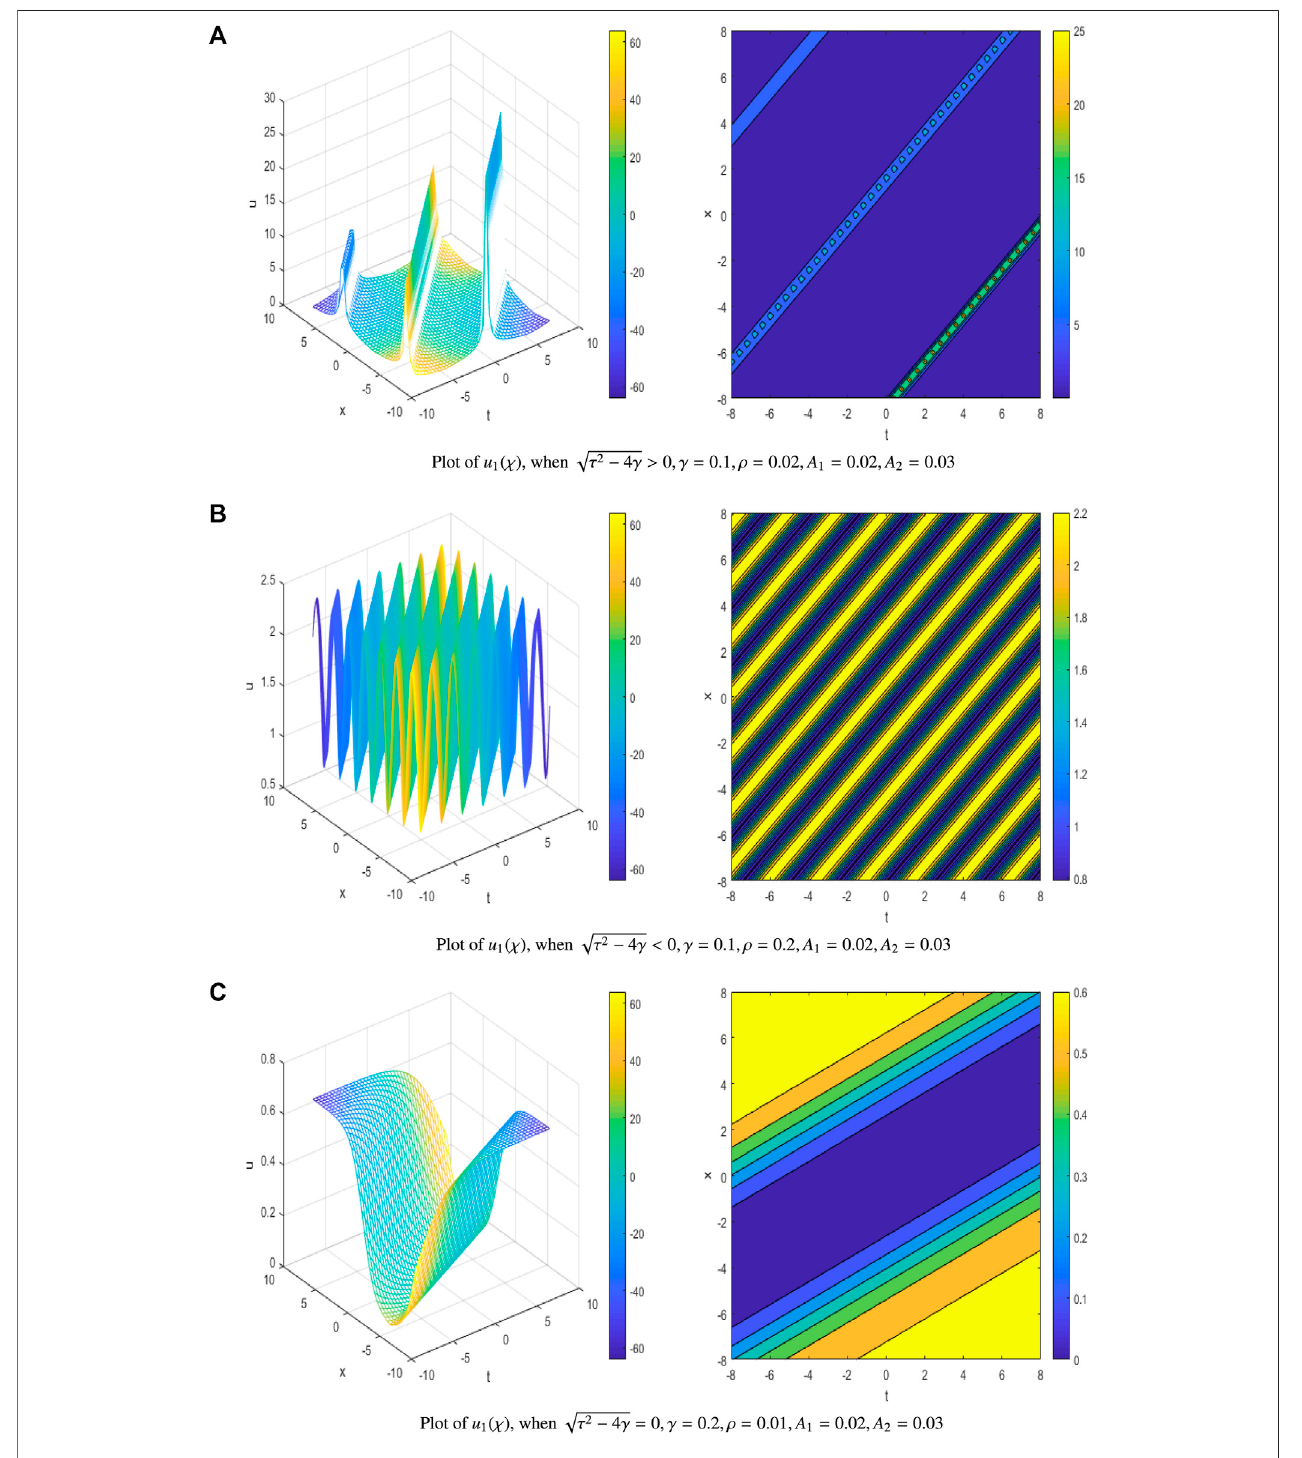
FIGURE1| TravelingwavesolutioncorrespondingtotheSharma-Tasso-Olver(STO)equation. (A) Plotof u (B) Plot of u